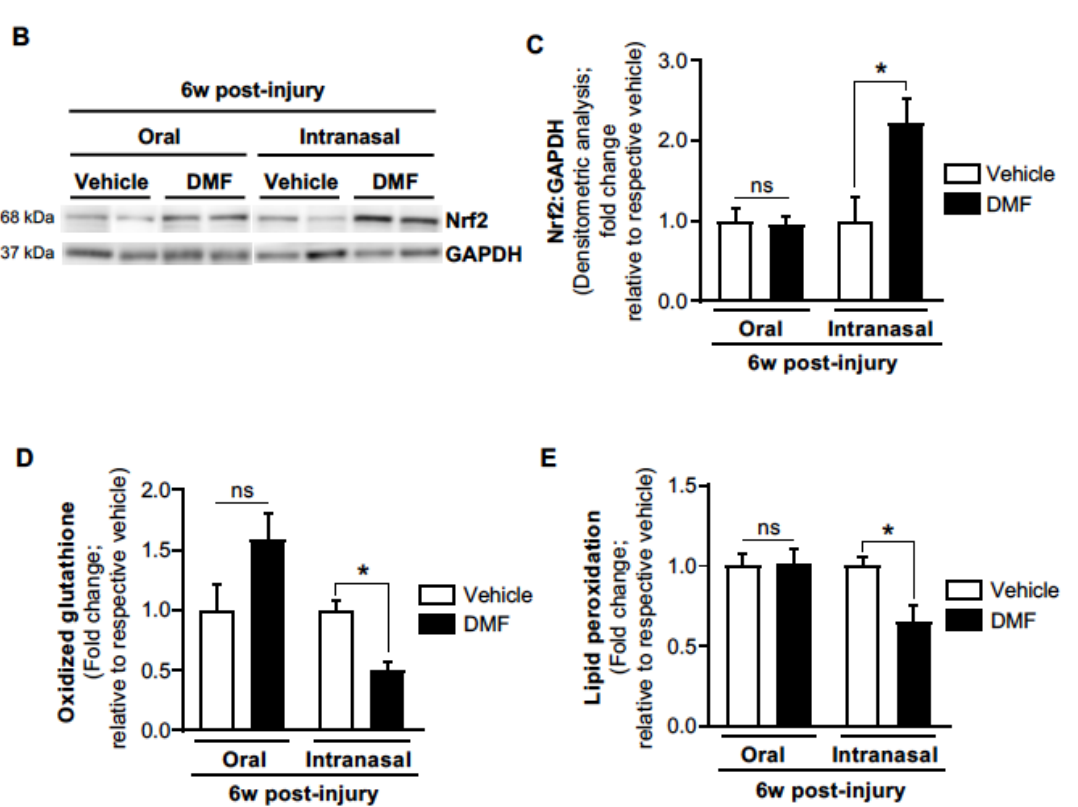
Figure 5. Intranasal (but not oral gavage) administration of DMF restores lung Nrf2 levels in aged-injured mice. ( A ) Blood ROS levels were analyzed by Amplex Red assay. Oral-DMF ( n = 7); intranasal-DMF ( n = 6). ( B , C ) Lung protein extract was assessed for Nrf2 expression by Western blot ( B ) and densitometric analysis ( C ). Representative Western blot images are shown. Oral-vehicle ( n = 7); oral-DMF ( n = 7); intranasal-vehicle ( n = 4); intranasal-DMF ( n = 4). ( D ) The level of lung oxidized glutathione was analyzed by a quantitative oxidized glutathione assay. Oral-vehicle ( n = 5); oral-DMF ( n = 5); intranasal-vehicle ( n = 3); intranasal-DMF ( n = 4). ( E ) The level of lung lipid peroxidation was analyzed by quantitative lipid peroxidation assay. Oral-vehicle ( n = 5); oral-DMF ( n = 5); intranasal-vehicle ( n = 4); intranasal-DMF ( n = 3). All values represent means of biological replicates ± SEM; ns: not significant; * p < 0.05; ** p < 0.01 using Student’s two -tailed t -test.